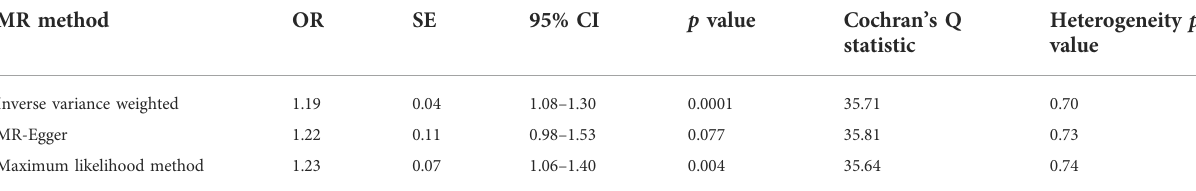
TABLE 2 MR estimates from each method of the causal effect of tea consumption on osteoarthritis risk.